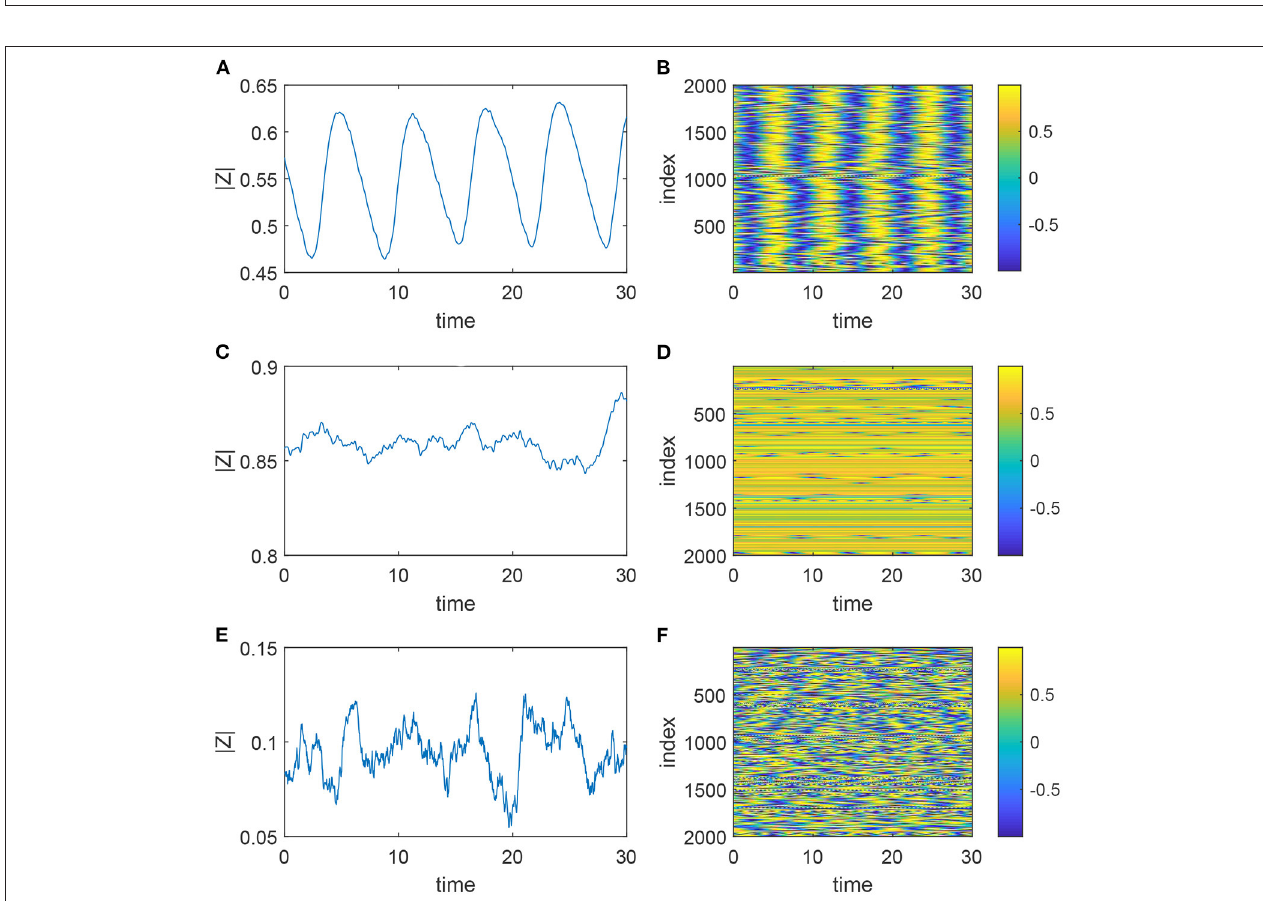
FIGURE 2 | (A) Correlation coefficient between the in- and out-degrees of an oscillator, ρ , as a function of the parameter function Q ( k in ,